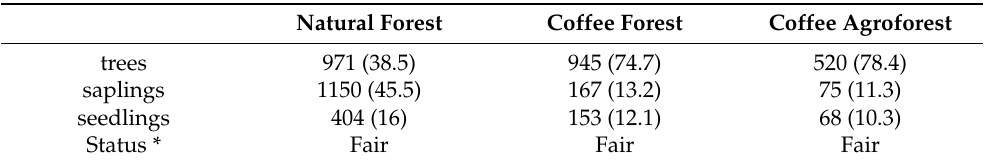
Table 6. Total number of mature trees, saplings and seedlings and regeneration status in the natural forest, coffee forest and coffee agroforest.